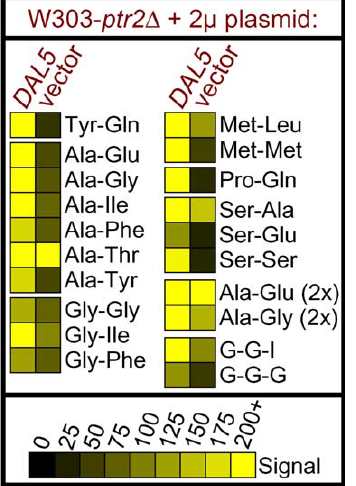
Figure 5. Utilization of a Subset of Dipeptides Is Enhanced in W303- ptr2 D upon Overexpression of DAL5 Strain W303- ptr2 D was transformed with either the vector pRS426 or the plasmid pRS426- DAL5 , a 2- l m plasmid containing a genomic fragment including DAL5, and phenotyped using the PM assay. The nitrogen sources shown comprise all instances in which the signal values met our reliability criteria (see Figure 2) and the presence of pRS426- DAL5 altered the signal value by more than 50 units relative to the vector control. Dipeptides followed by ‘‘ (2 3 ) ’’ are present in the PM assay plates at twice the concentration of the other dipeptides. DOI: